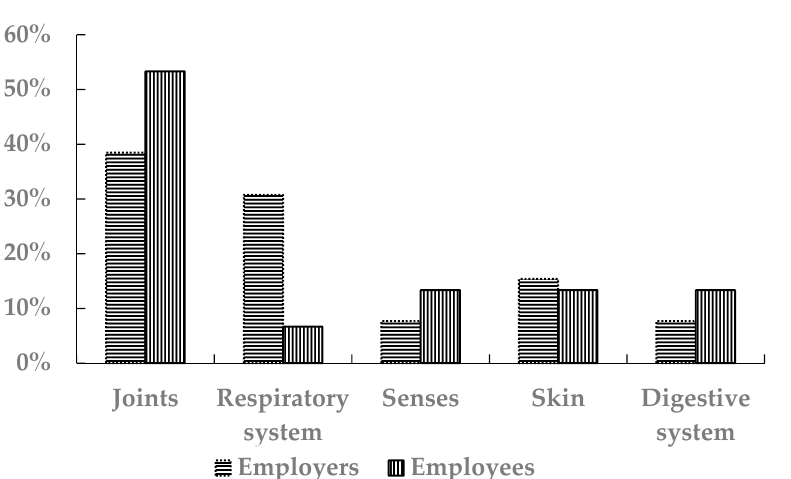
Figure 8. The percentages of the types of the occupational disease in the industrial sectors for the employees and the employers.